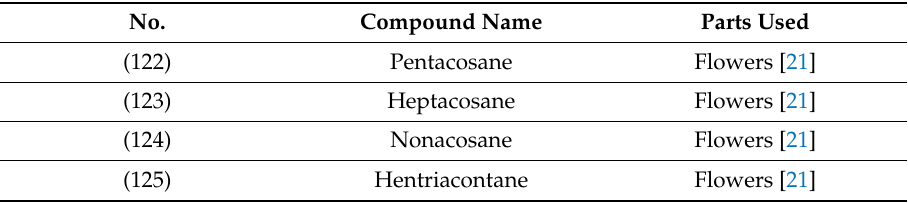
Table 6. Hydrocarbons from Brugmansia suaveolens